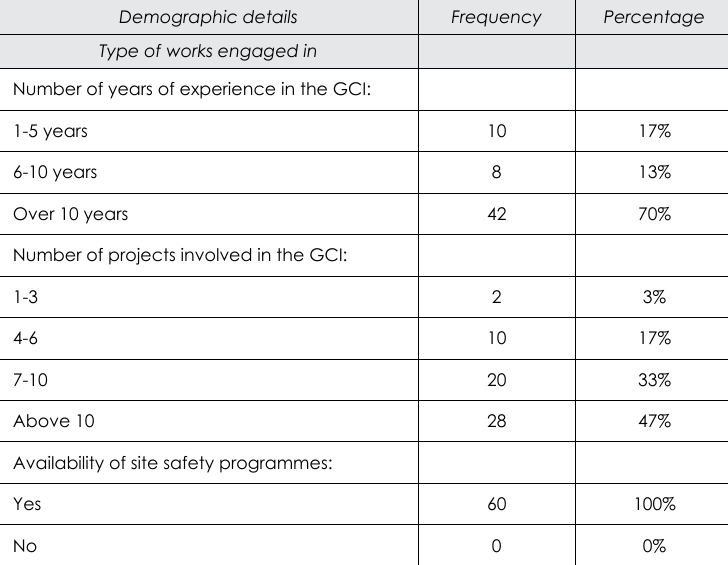
Demographic characteristics of respondents Demographic details Frequency